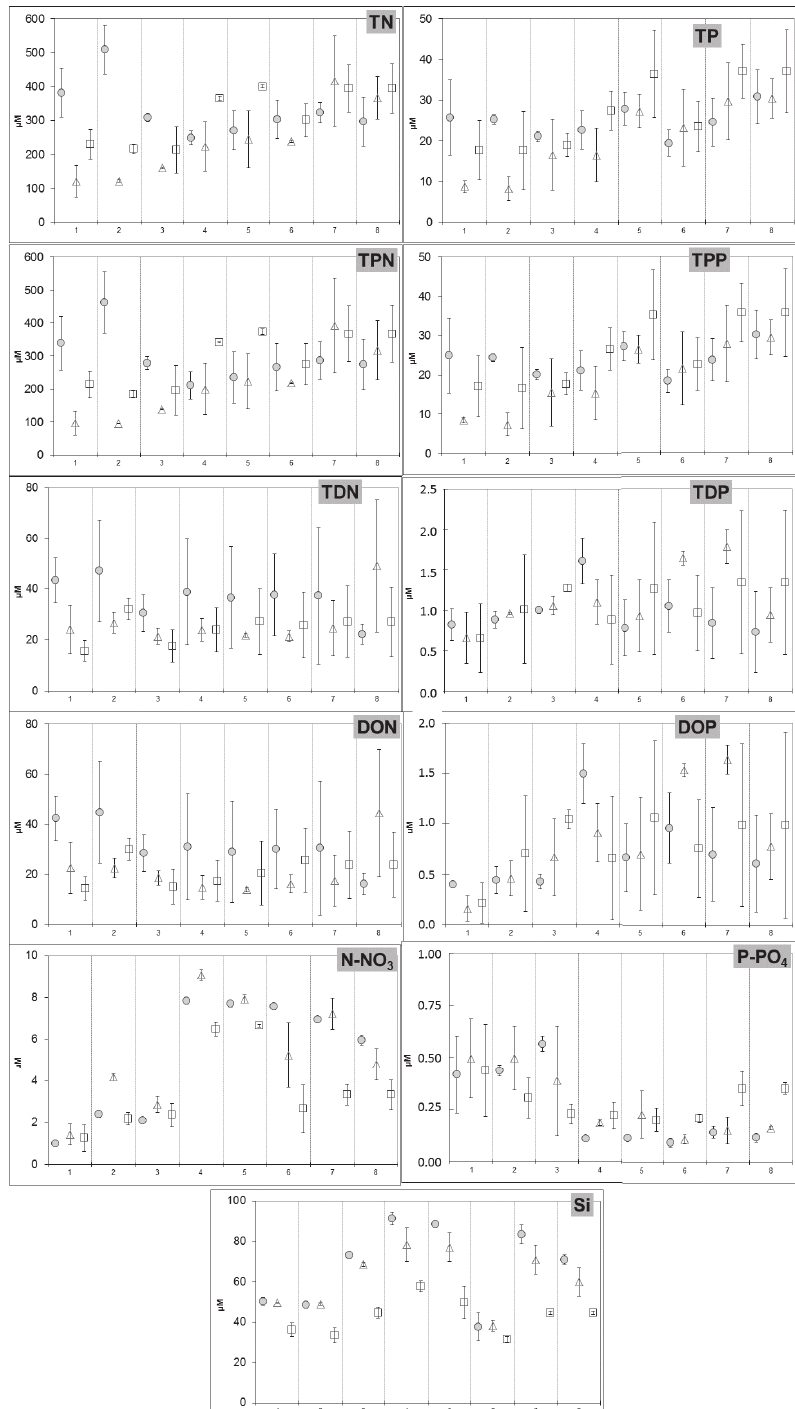
Figure 6 - Variations in total nitrogen concentrations – TN (A) , total phosphorus – TP (B) , total dissolved nitrogen – TDN (C) , total dissolved phosphorus – TDP (D) , nitrate (E) , phosphate (F) and silicate (G) at the eight stations, related to dry (circles), intermediate (triangles) and wet (squares) periods. Averages and standard error for each sampling point. Nitrite and ammonia concentrations are not shown because they were very close to the detections